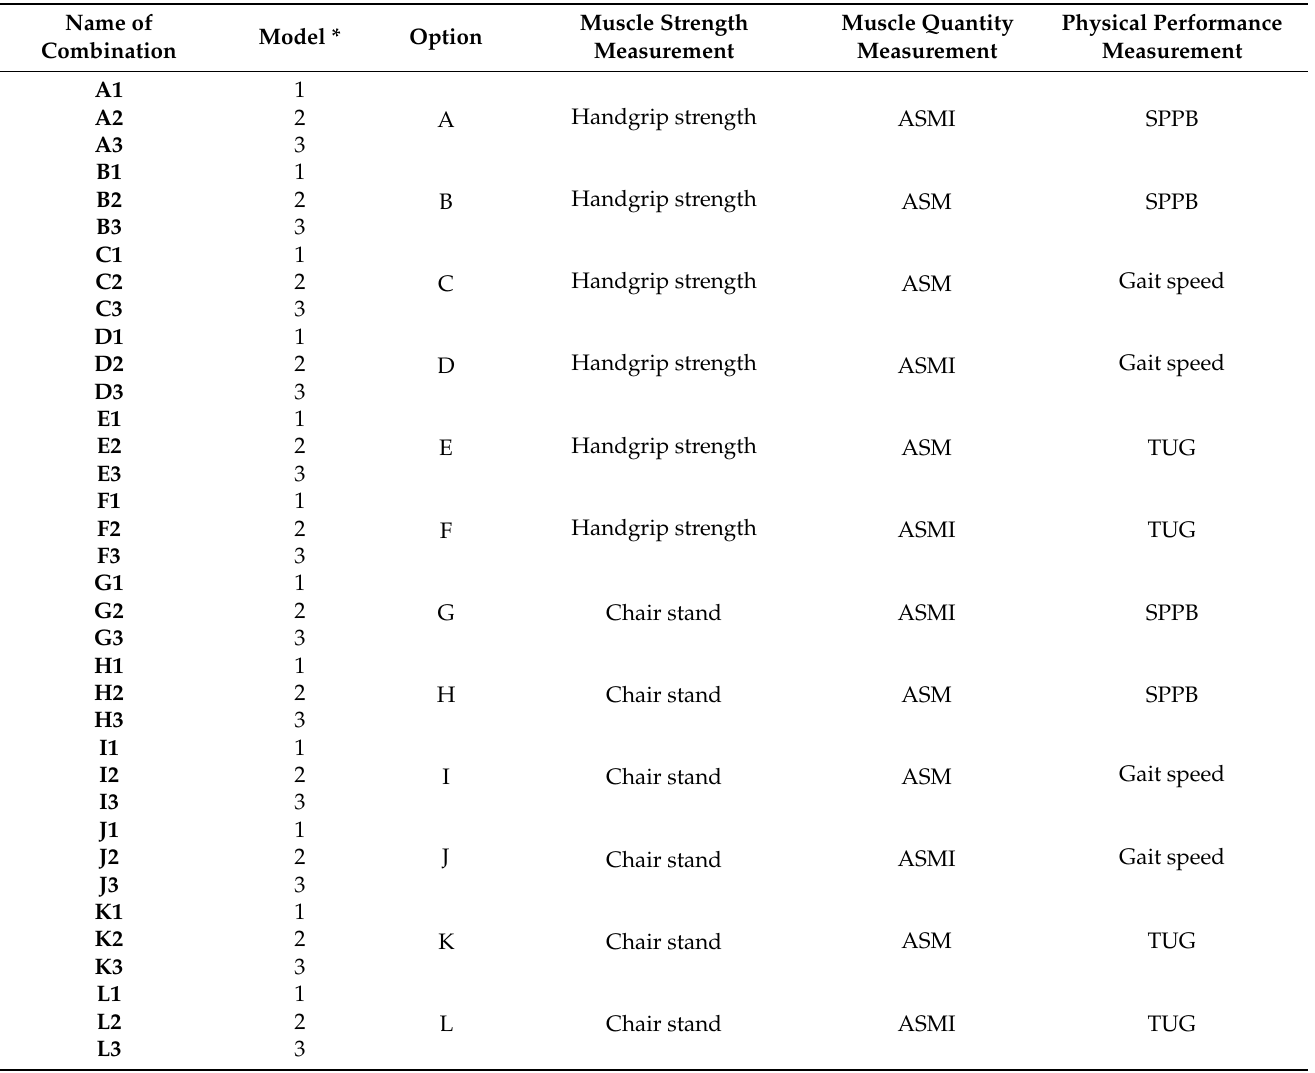
Table 1. Description of the three models and their 12